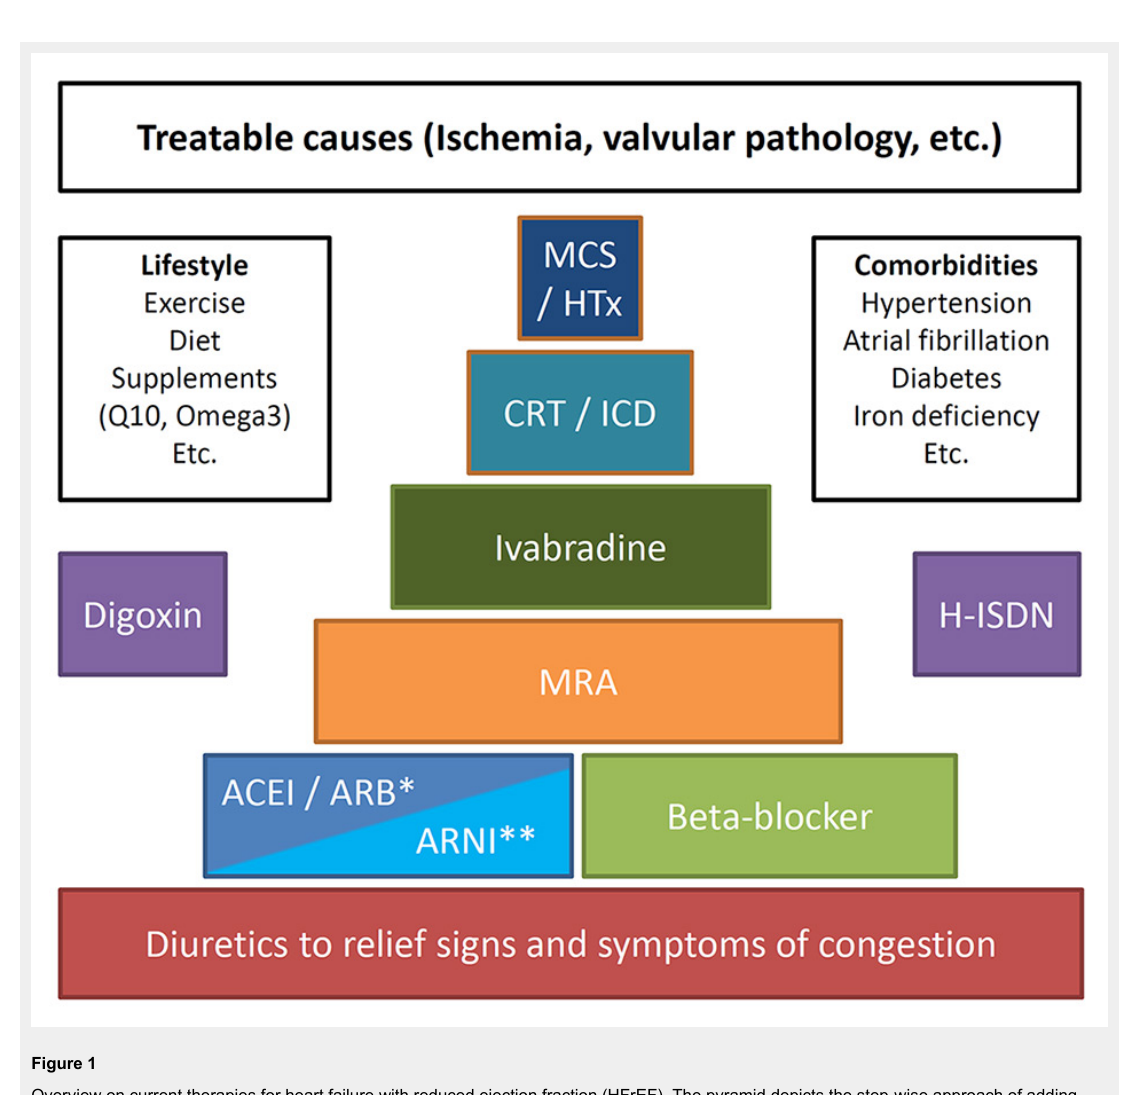
Figure 1 Overview on current therapies for heart failure with reduced ejection fraction (HFrEF). The pyramid depicts the step-wise approach of adding evidence-based treatments as recommended by the 2012 ESC guidelines [9]. The white boxes reflect additional factors that are important for the treatment of HFrEF independent of the standard treatments. Not all therapies are subjects of this review and for detailed recommendations review of the guidelines is recommended [5]. *An ARB is recommended when an ACEI is not tolerated ** The position of ARNIs in the treatment cascade will be defined in the next ESC heart failure guidelines and was thus not more clearly defined in this figure. ACEI = angiotensin converting-enzyme inhibitor; ARB = angiotensin receptor blocker; ARNI = angiotensin receptor neprilysin inhibitor; CRT = cardiac resynchronisation therapy; ICD = implantable cardioverter defibrillator; H-ISDN = hydralazine-isosorbide dinitrate; HTx = heart transplantation; MCS = mechanical circulatory support; MRA= mineralocorticoid antagonist; omega3 = omega-3 polyunsaturated fatty acids; Q10 = coenzyme